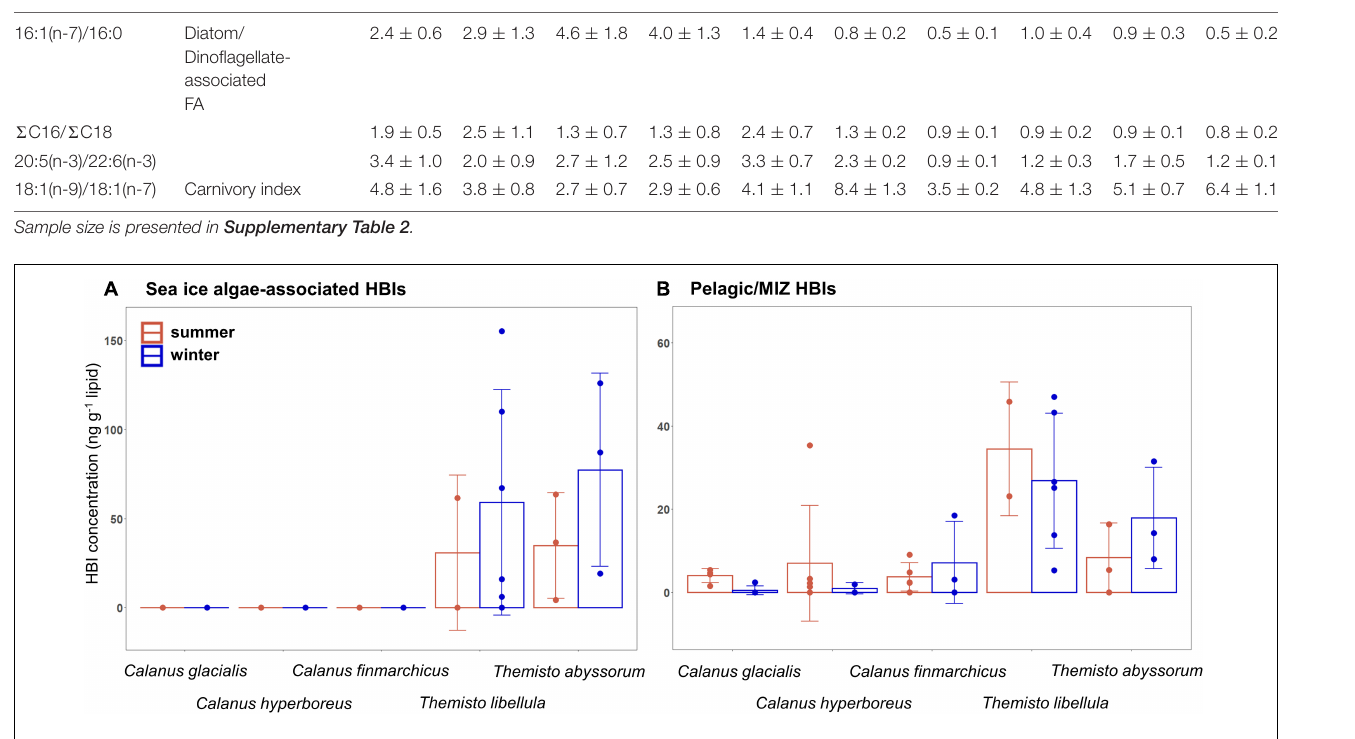
lower in summer than in winter in C. finmarchicus and T. abyssorum ( Figure 5B ).